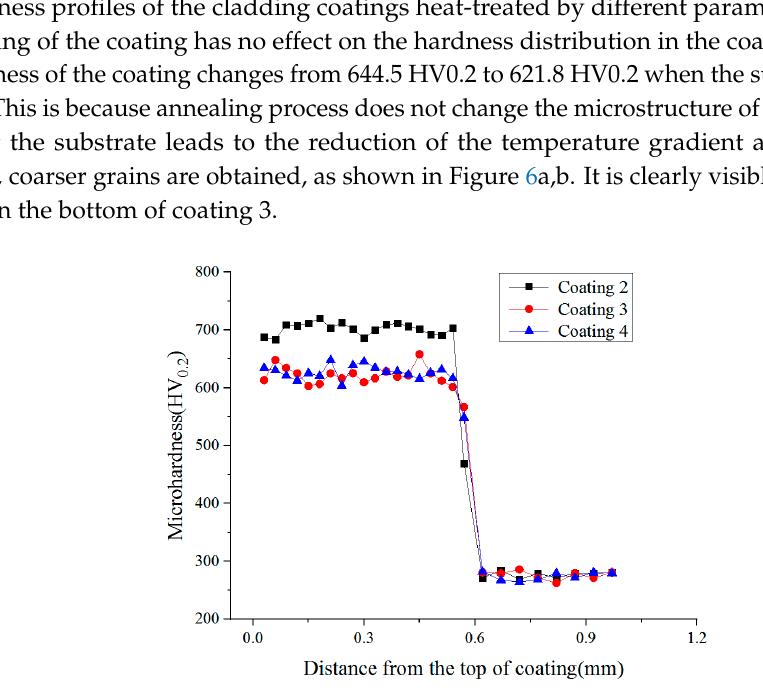
Figure 6. Microstructures of coating 2 and coating 3. ( a ) Coating 2 (annealing at 300 °C for 1 h), ( b ) coating 3 (preheated to 250 °C).